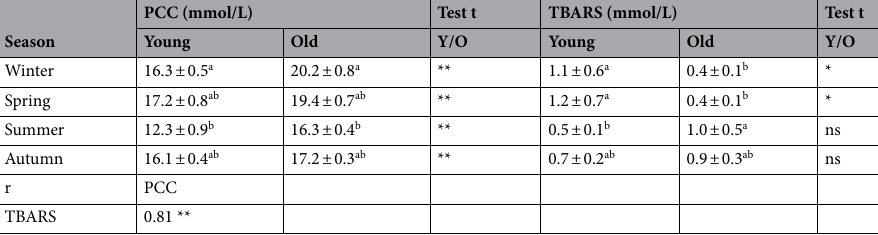
Table 4. Concentrations of oxidative stress parameters in the blood serum of younger and older bulls in relation to different season (mean ± SD). Description: Values with different letters (a, b) differ significantly between rows at P < 0.05. PCC protein carbonyl content, TBARS thiobarbituric acid reactive substrates. Test T—t-Student’s test, ** P ≤ 0.01; * P ≤